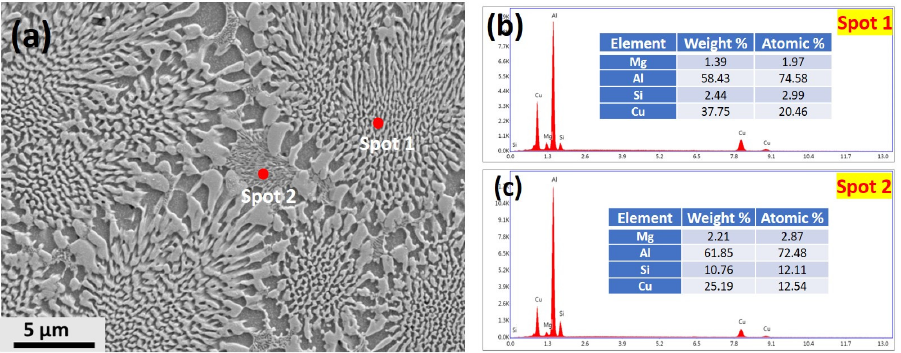
Figure 4. ( a ) SEM secondary electron image taken from a transverse section at half-length of the sample under high magnification ( b , c ) SEM-EDX point analyses of Spot 1 and Spot 2 obtained from ( a ).